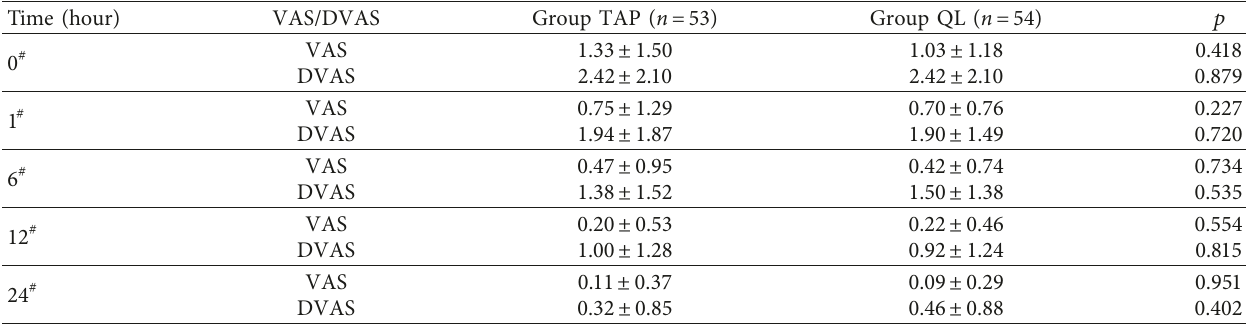
Table 4: VAS and DVAS